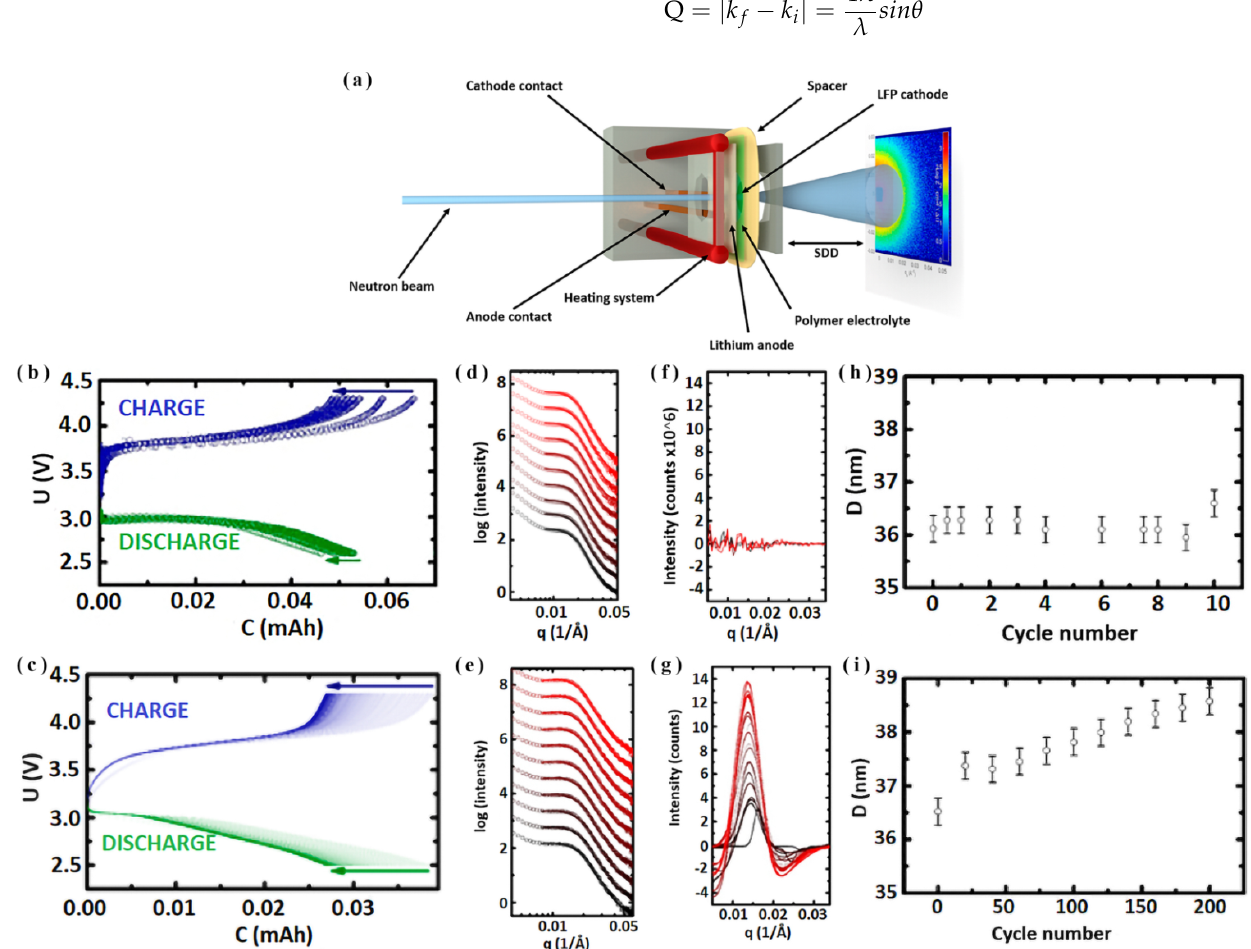
Figure 5. ( a ) Graphic for complete battery Operando SANS configuration, battery capacity-voltage diagram cycled at a rate of ( b ) 0.5 C for 10 cycles from 2.6 to 4.2 V, and ( c ) 0.7 C for 200 cycles between 2.4 and 4.3 V, SANS radial profiles during battery cycling from ( d ) cycle 0 (black) to cycle 10 (red), and ( e ) cycle 0 (black) to cycle 200 (red), ( f ) initial frame subtracted SANS data shown in Figure 5d, ( g ) Gaussian fits the first frame of SANS data shown in ( e ), periodic distances of structures in polymer electrolyte SDBCE from SANS fits using hexagonally packed cylinder SPE morphology at ( h ) 0.5 C for 10 cycles between 2.6 to 4.2 V and ( i ) 0.7 C for 200 cycles between 2.4 and 4.3 V (adapted with permission from Ref. [35]. 2018 American Chemical Society).